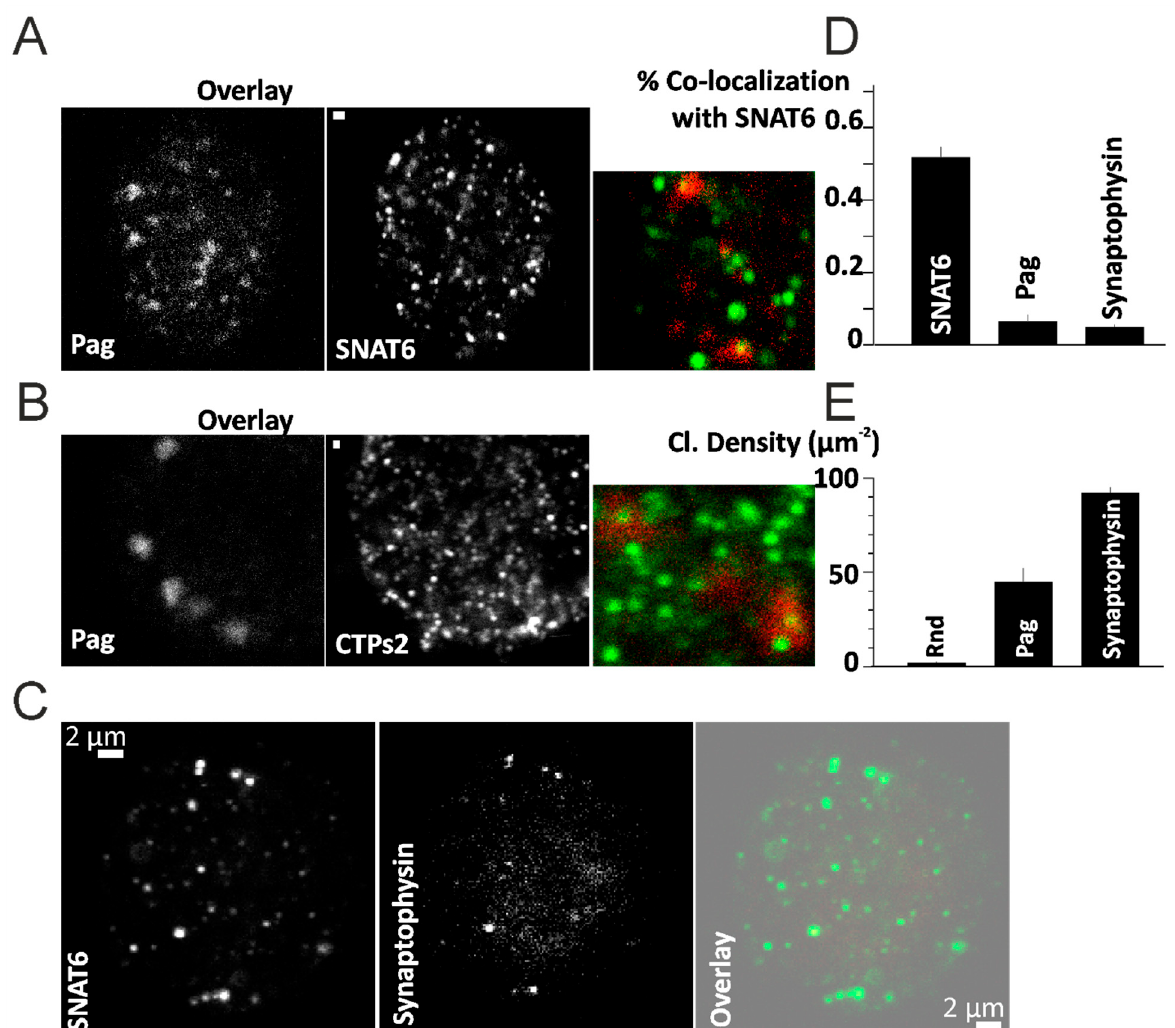
Figure 2. Localization of Pag and Synaptophysin. ( A ) Immunostained images of Pag and SNAT6 with an overlay image in the inset. ( B ) Immunostained images of Pag and CTPs2 with an overlay image in the inset. Scale bar 2 µ M in ( A , B ). ( C ) Immunostained images of SNAT6 and Synaptophysin with an overlay image on the right. Scale bar 2 µ M in ( C ). ( D ) Co-localization of SNAT6 with Pag and Synaptophysin measured as described in the methods. Random (Rnd) regions selected were used as control. Both Pag and Synaptophysin co-localized with SNAT6 at a significantly ( p < 0.001) higher percentage compared to Rnd regions ( E ) Density of clusters of SNAT6, Pag and Synaptophysin was assessed as described in the methods. Note of density of SNAT6 which is significantly ( p < 0.001) higher than Pag or Synaptophysin. All the experiments in the figure were repeated for 2 − 3 times each with each of the bar graph representing more than 15 cells obtained from separate experiments.